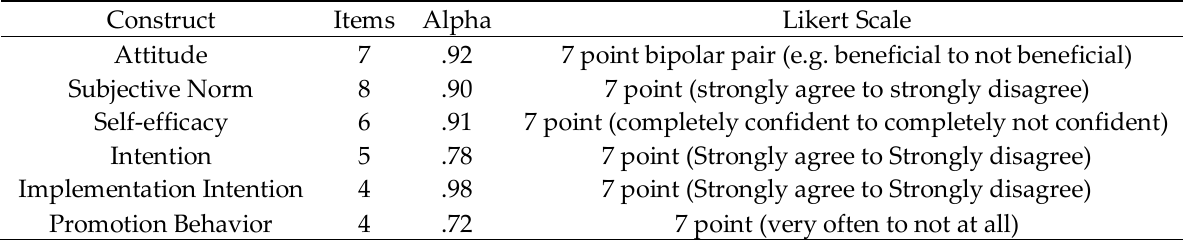
Table 2. Description, number of items and reliability of instruments with Cronbach’s